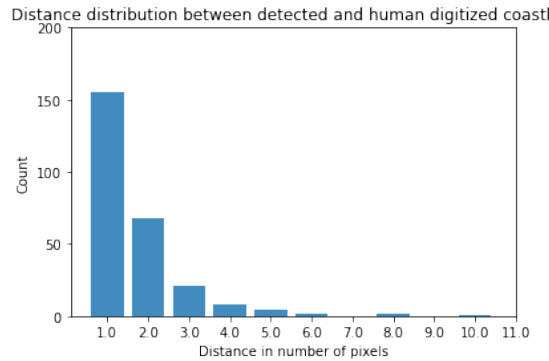
Figure 10. The graph depicts the distribution of the distance between the manually digitized coastline and the detected coastline. To compute it, about 360 points were selected on the digitized coastline with a 50 m spacing and the minimum distance to the detected coastline is computed.